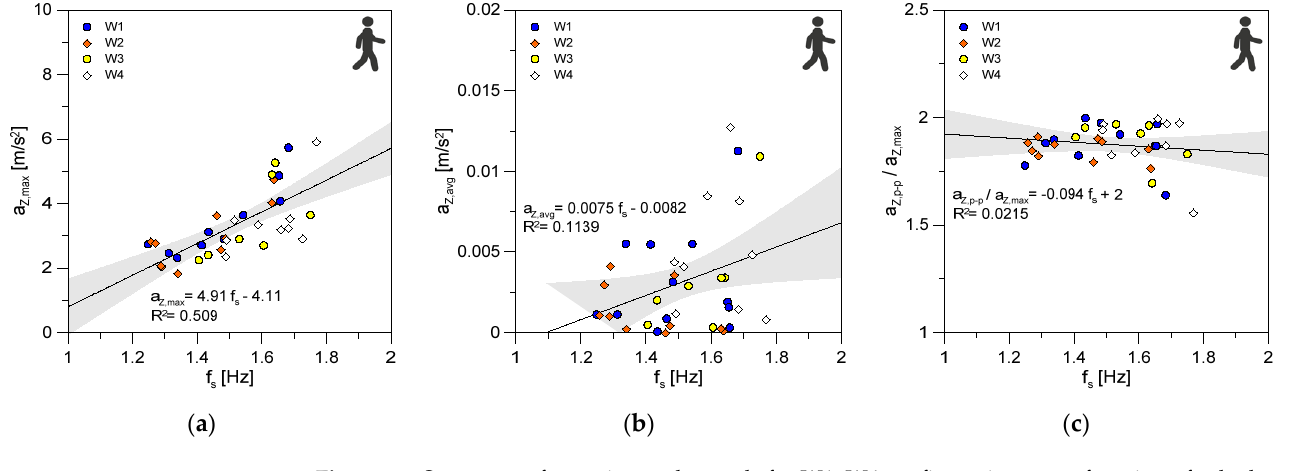
Figure 10. Summary of experimental records for W1-W4 configurations: ( a ) Gaussian distribution of samples (40 in total), ( b ) stride length, ( c ) walking speed, ( d ) average stride interval, ( e ) stride interval variation. The 95% confidence interval is shown in grey colour.